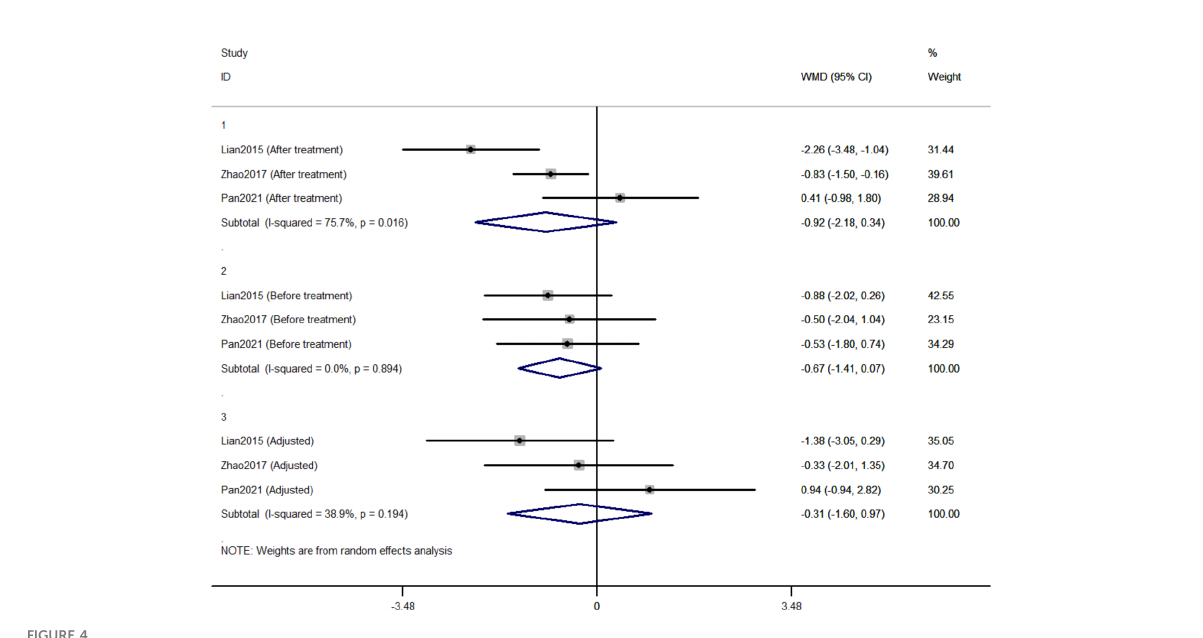
FIGURE 4 Forest plots of changes in 2h-PG between Jinlida Groups and Control